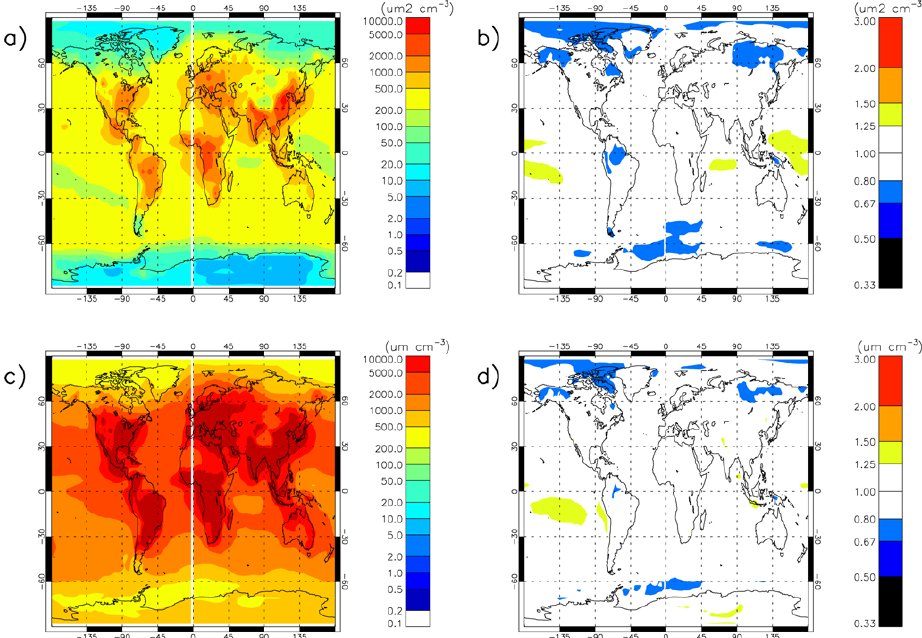
Fig. 11. Global surface maps showing (a) aerosol dry surface area density (SADdry) and (c) dry condensation sink (CS dry ) in the continuum regime as simulated by GLOMAP-mode (v6R) on the annual-mean. The ratio of GLOMAP-mode (v6R) to GLOMAP-bin simulated SAD dry and CS dry are shown in panels (b, d) , respectively. Regions coloured yellow, orange and red in the relative bias maps indicate where GLOMAP-mode is higher than bin by 25–50, 50–100 and 100–200%, respectively, whilst light-blue, dark-blue and black indicate where bin is higher by the same proportions. Regions where the two schemes are within 25% are colored